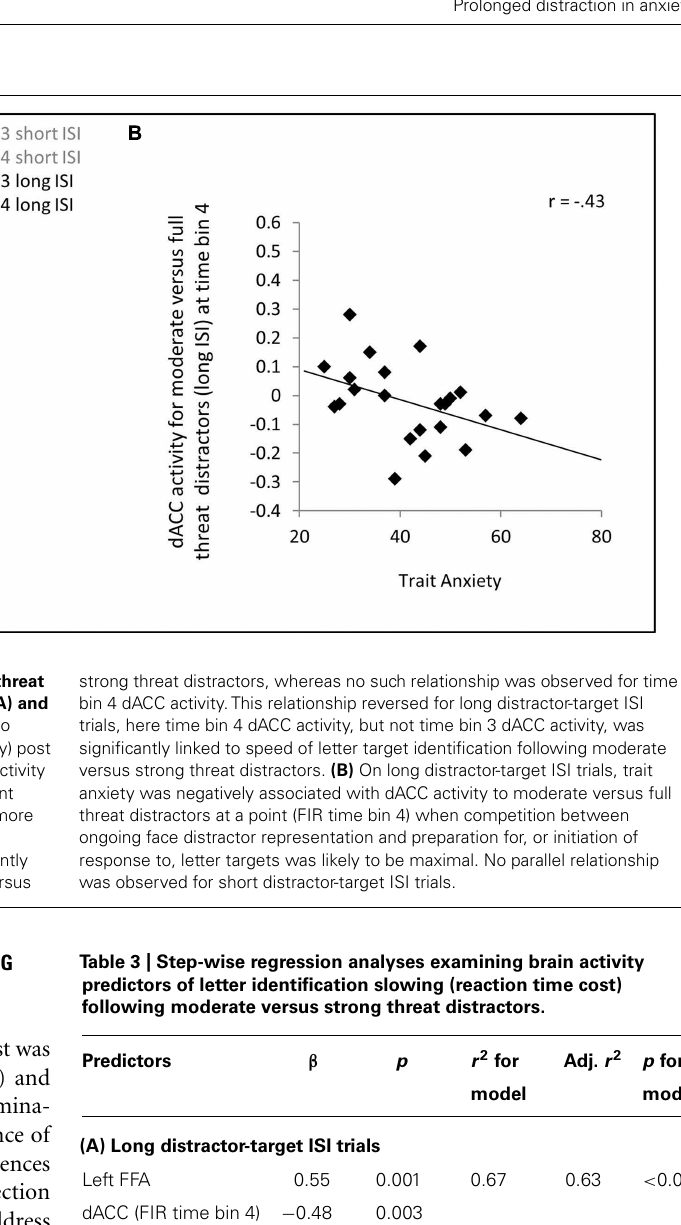
Table 3 | Step-wise regression analyses examining brain activity predictors of letter identification slowing (reaction time cost) following moderate versus strong threat